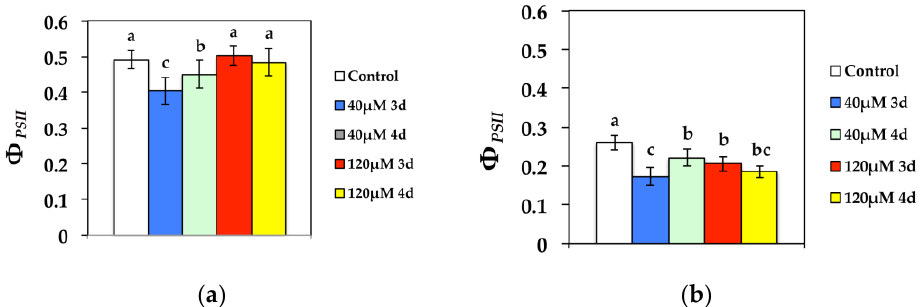
Figure 2. Changes in the quantum efficiency of PSII photochemistry ( Φ PSII ) in N. caerulescens measured ( a ) at 300 μmol photons m − 2 s − 1 or ( b ) 1000 μmol photons m − 2 s − 1 . N. caerulescens plants were grown at 0 (control), 40, or 120 μ M Cd 2+ for 3 and 4 days.